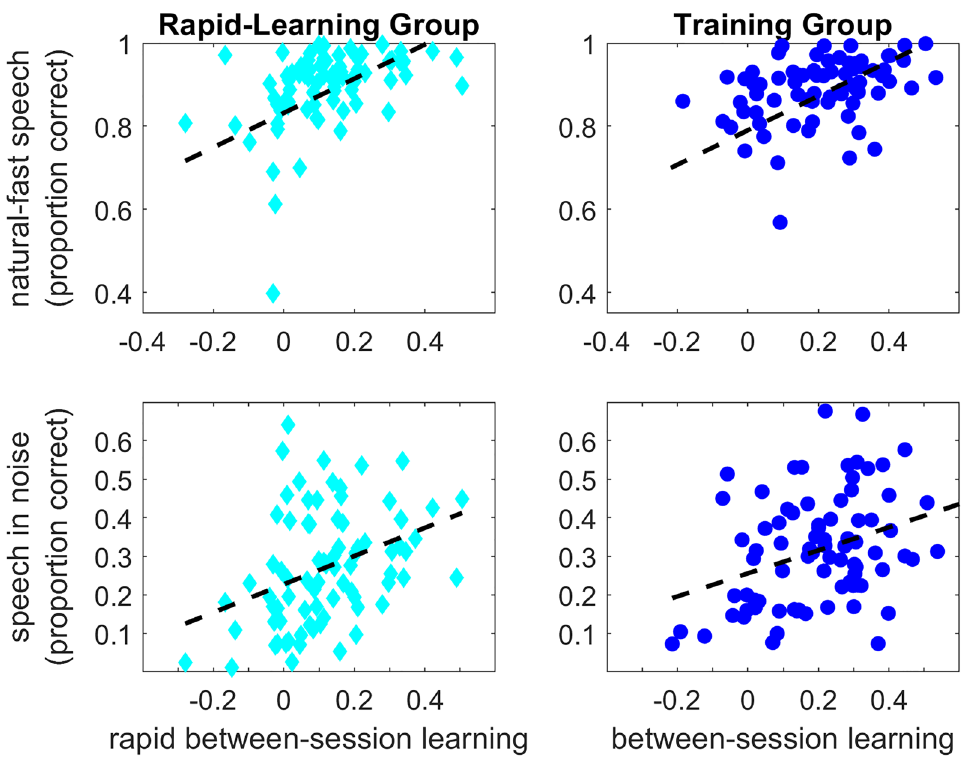
Figure 5. Speech recognition versus perceptual learning. Proportions correct in session 2 are plotted against between-session learning of time-compressed speech expressed as the difference in recognition accuracy between the two sessions for each participant. Dashed lines show linear fits. For visualization only, learning scores were adjusted to partial out the contribution of baseline recognition of time-compressed speech (as in Manheim et al., 2018). Therefore, values on the x axes are not the same as the simple difference scores shown in Fig. 2.